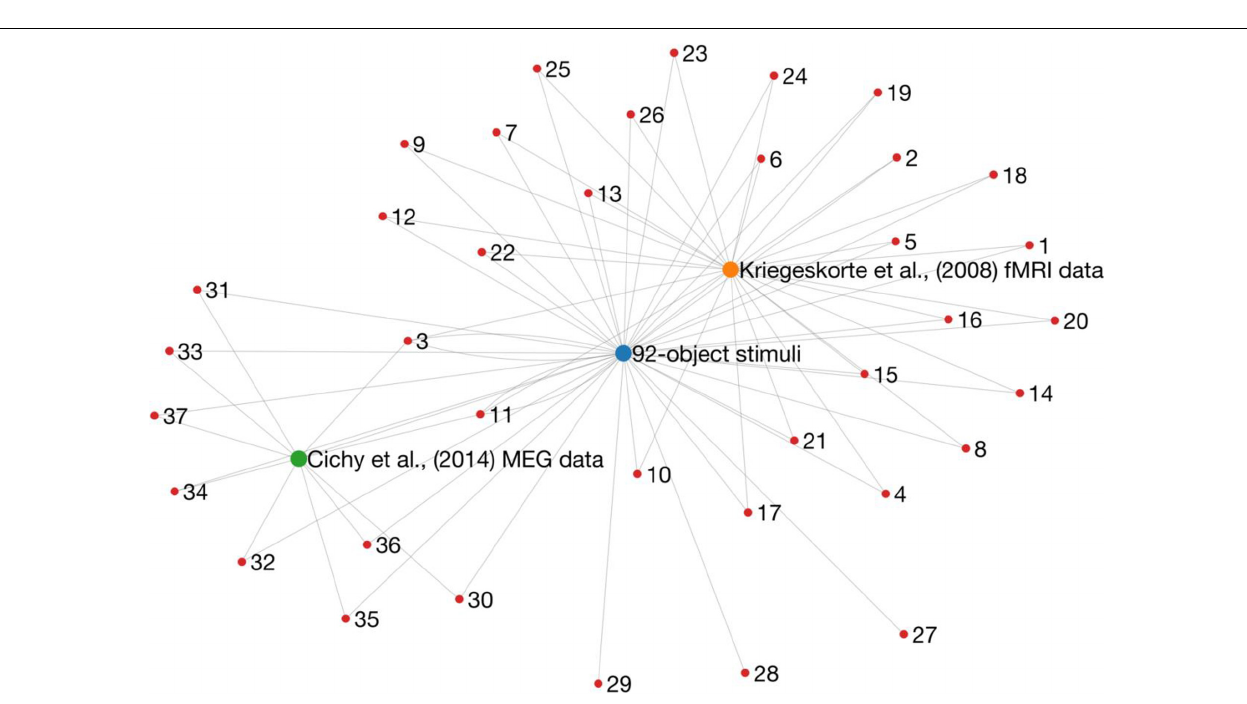
FIGURE 1 | The 92-object stimulus set used in over 35 computational cognitive neuroscience papers. Some of the objects in the “animate” category are not animate (e.g., hair; row 1 column 5, or a cut-out wolf figurine; row 3 column 4). Some inanimate images are not objects, but rather scenes (e.g., row 6/7 column 1). This stimulus set is often used to highlight a strong animate/inanimate dichotomy in human brain responses, but the categories have consistent visual differences (the rightmost two columns show the means of all images in a category).